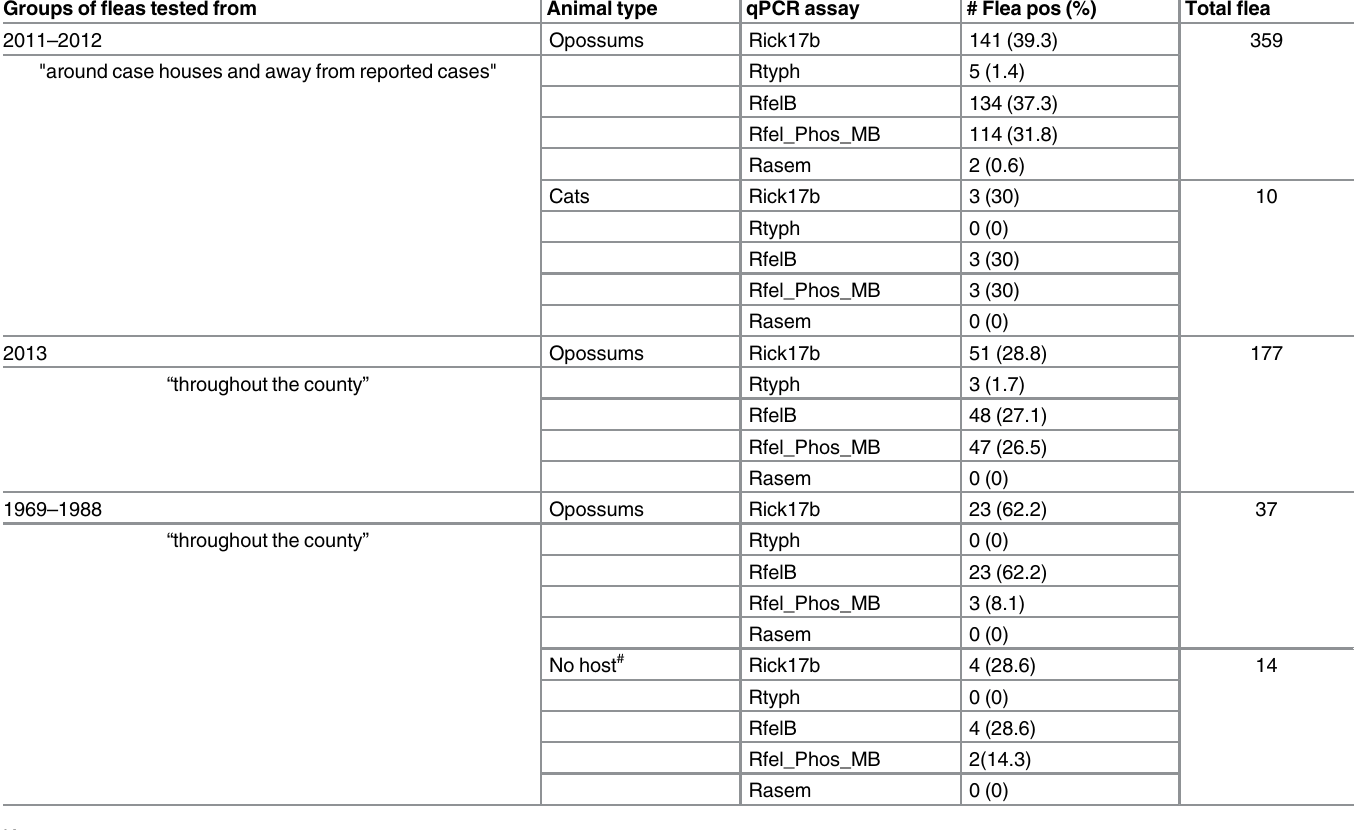
Key # Fleas were collected in the environment using “ white sock ”